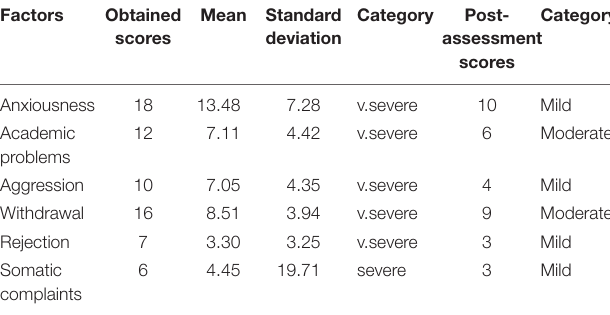
TABLE 4 | Scores, mean, standard deviation, and categories on School Children Problem